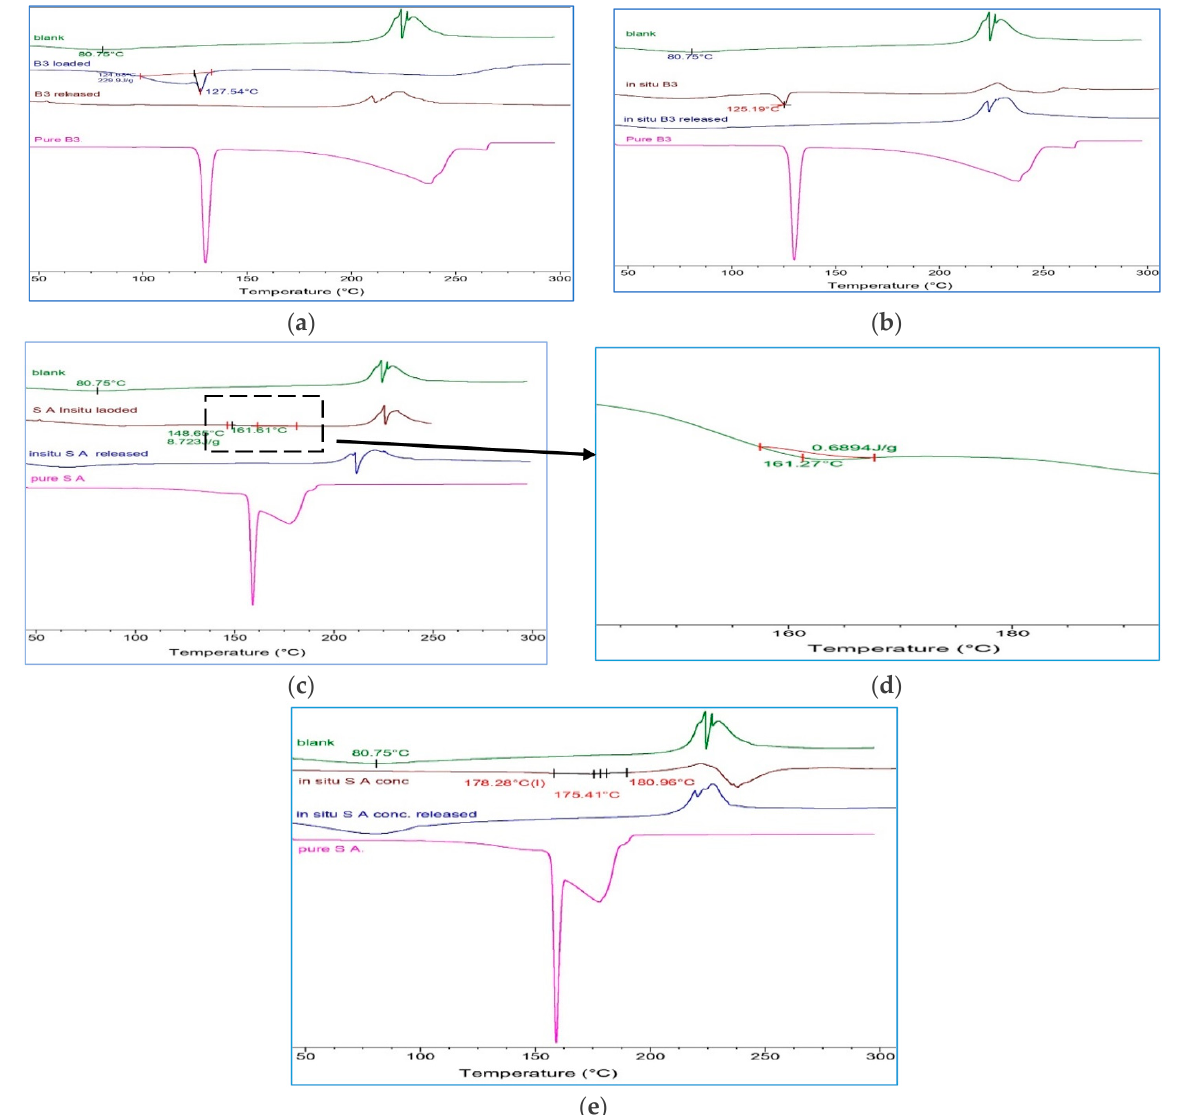
Figure 4. DSC thermograms ( a ) post-loaded B 3 (to compare the pure active, unmedicated film with loaded and released film from active). ( b ) In situ loaded B 3 (to compare the pure active, unmedicated film with active loaded and released film). ( c ) In situ 3.55% SA (to compare the pure SA, unmedicated film with active loaded and released film). ( d ) Enlarged in situ loaded 3.55% SA showing the thermogram peak of the SA. ( e ) In situ 45% w / w SA (to compare the pure active, unmedicated film with active loaded and released film).